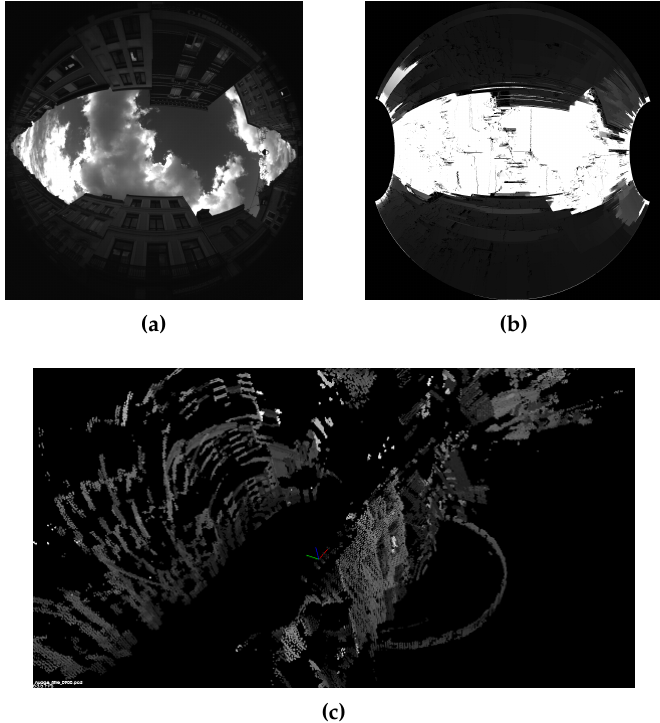
Figure 9. Distance map issued from the matching and resulting 3D model, scene Cap3/0900. ( a ) Initial rear image; ( b ) Distance map; ( c ) Filtered 3D point cloud.